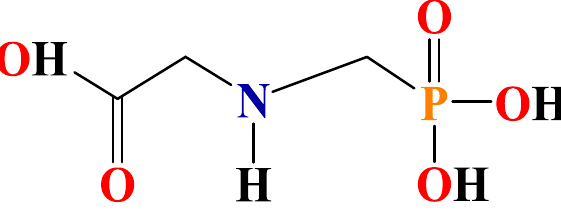
Figure 1. Chemical structure of glyphosate.